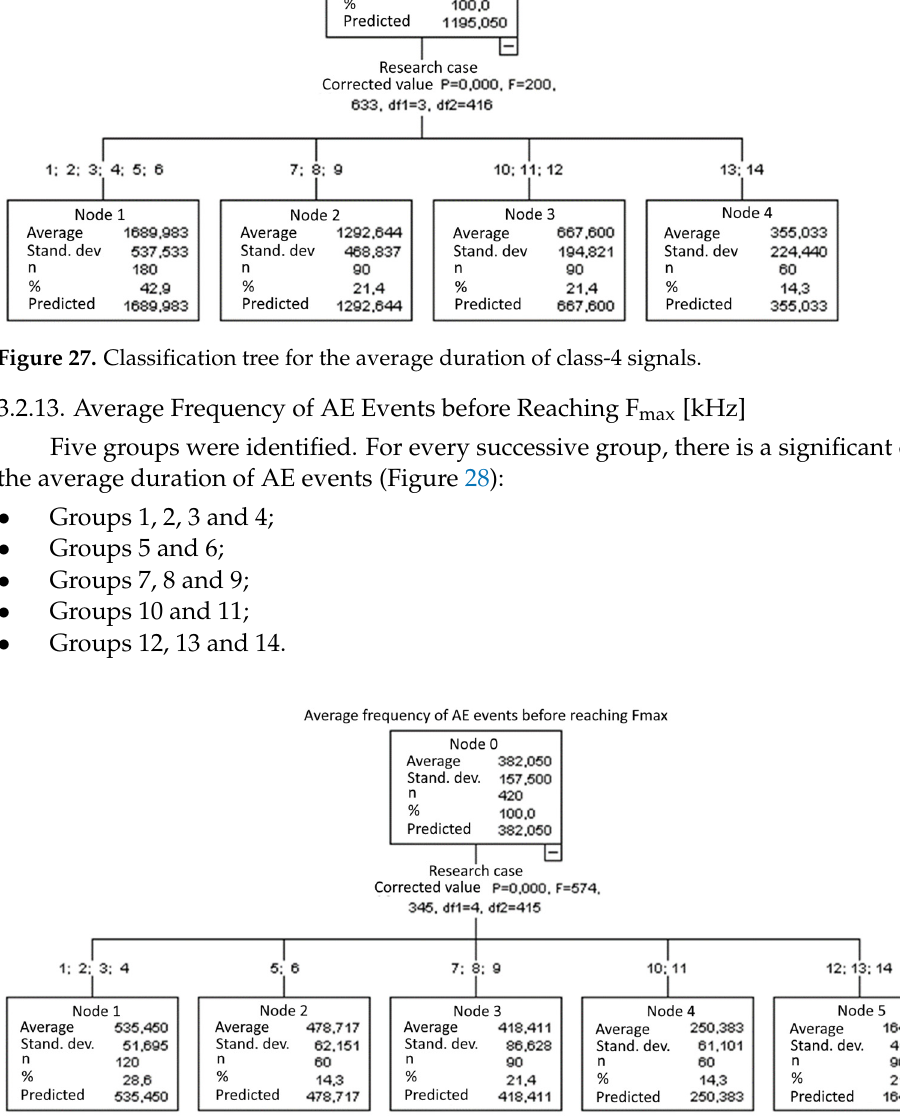
Figure 29. Classification tree for MOR bending strength. 3.3. Correlation between Parameters In order to test the normality of the data distribution, the Shapiro–Wilk test was per- formed. In most cases, the data are not normally distributed. Therefore, the Spearman correlation coefficient was used to investigate the relationship between the indicated changes. It was found that a significant correlation exists between: •